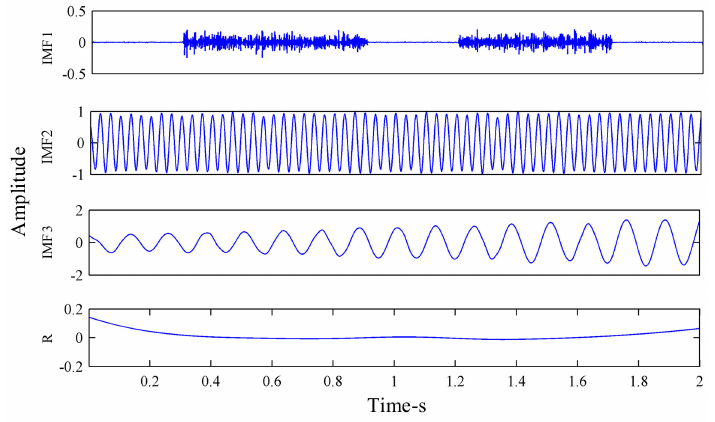
Figure 8. Modified ensemble empirical mode decomposition (MEEMD) decomposition of the synthe- sized